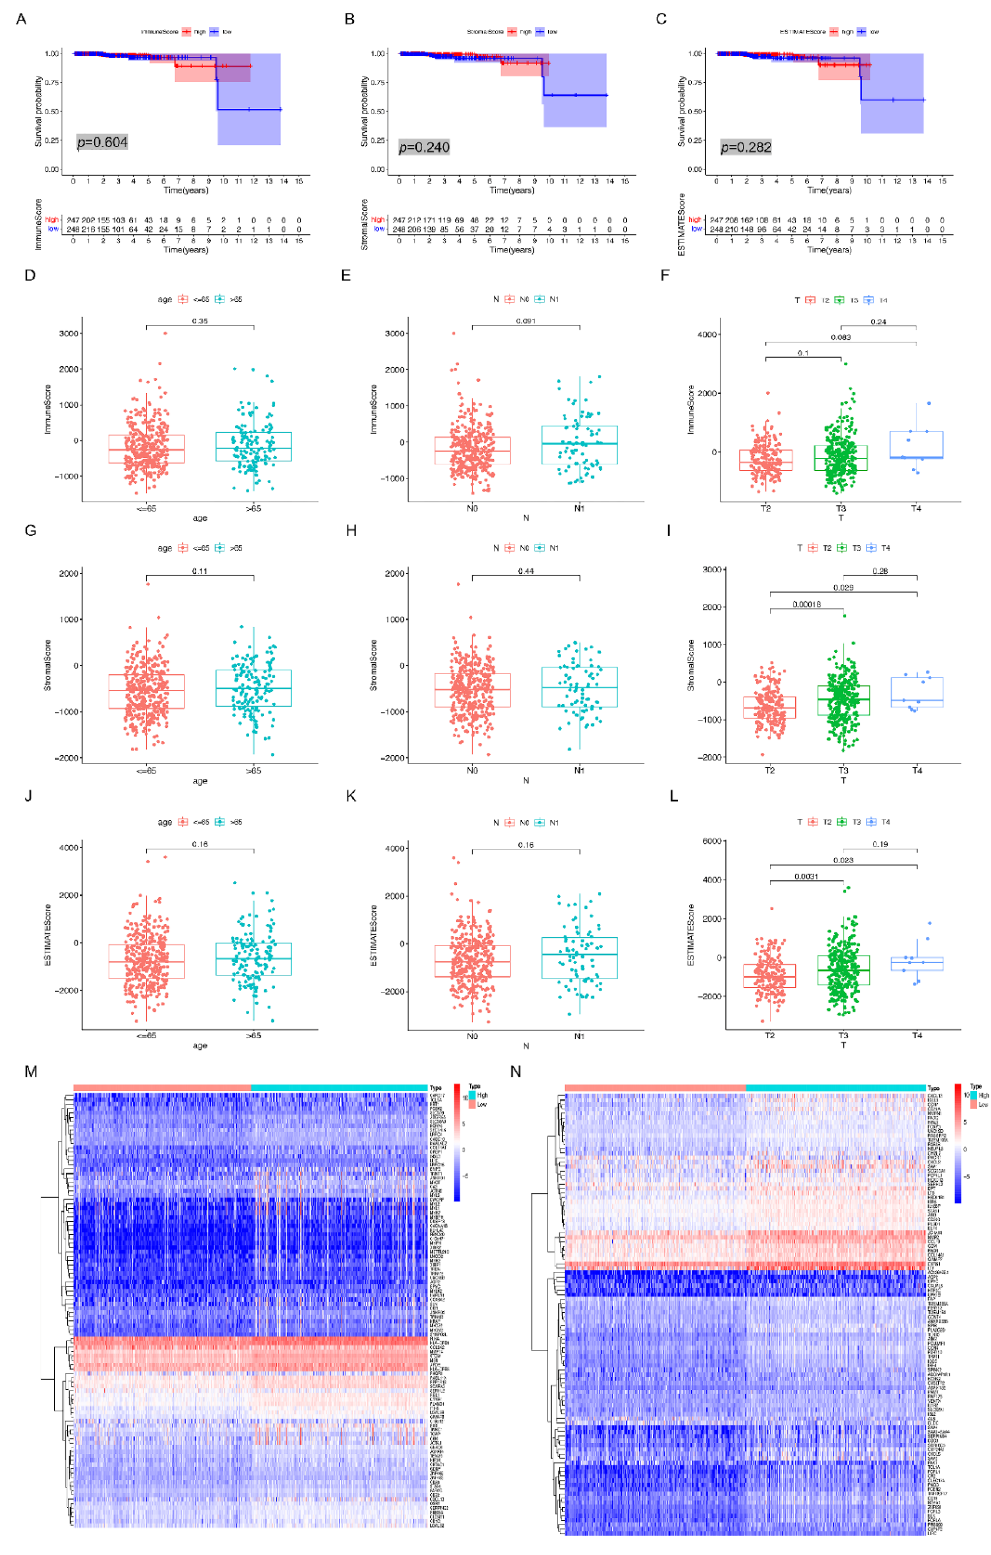
Figure 1. Correlation between three categories of scores with the prognosis and clinical characteristics of individuals with prostate cancer. ( A ) Kaplan–Meier survival analysis for high- and low-score